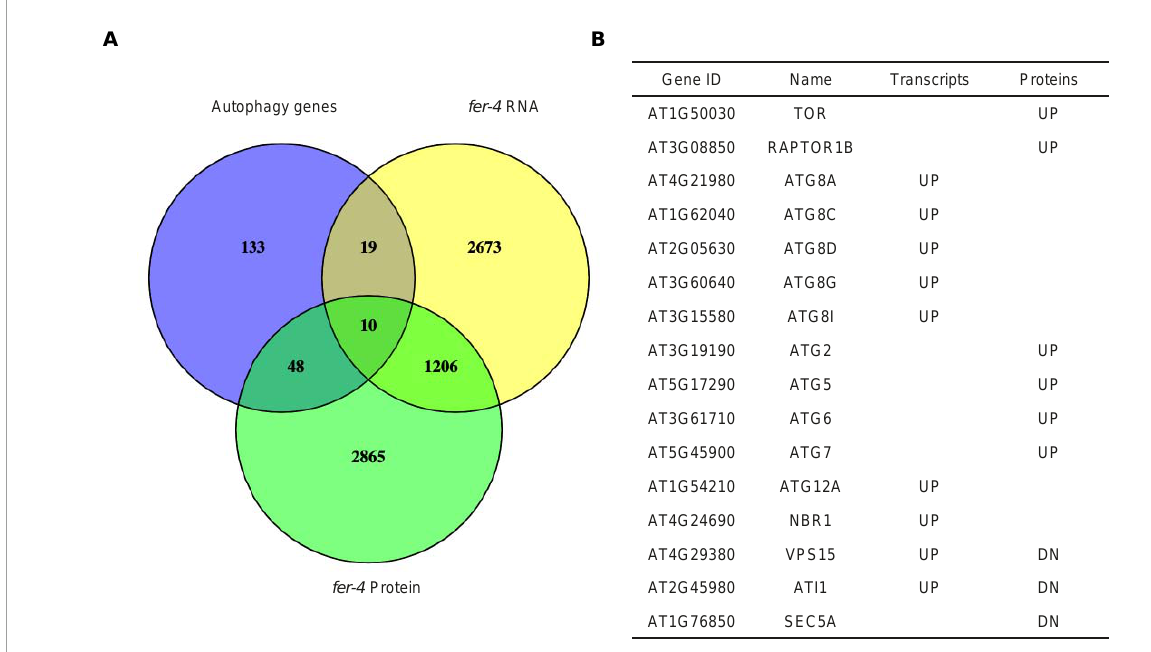
FIGURE1 Comparison of autophagy-related genes with transcriptome and proteome of fer-4 . (A) Venn diagram showing the overlaps among autophagy-related genes (Homma et al., 2011) and differentially expressed transcripts and proteins in fer-4 mutant. (B) Selected genes involved in autophagy and their changes in two sets of differentially expressed data (UP: increased levels in fer-4 mutant; DN: decreased levels in fer-4